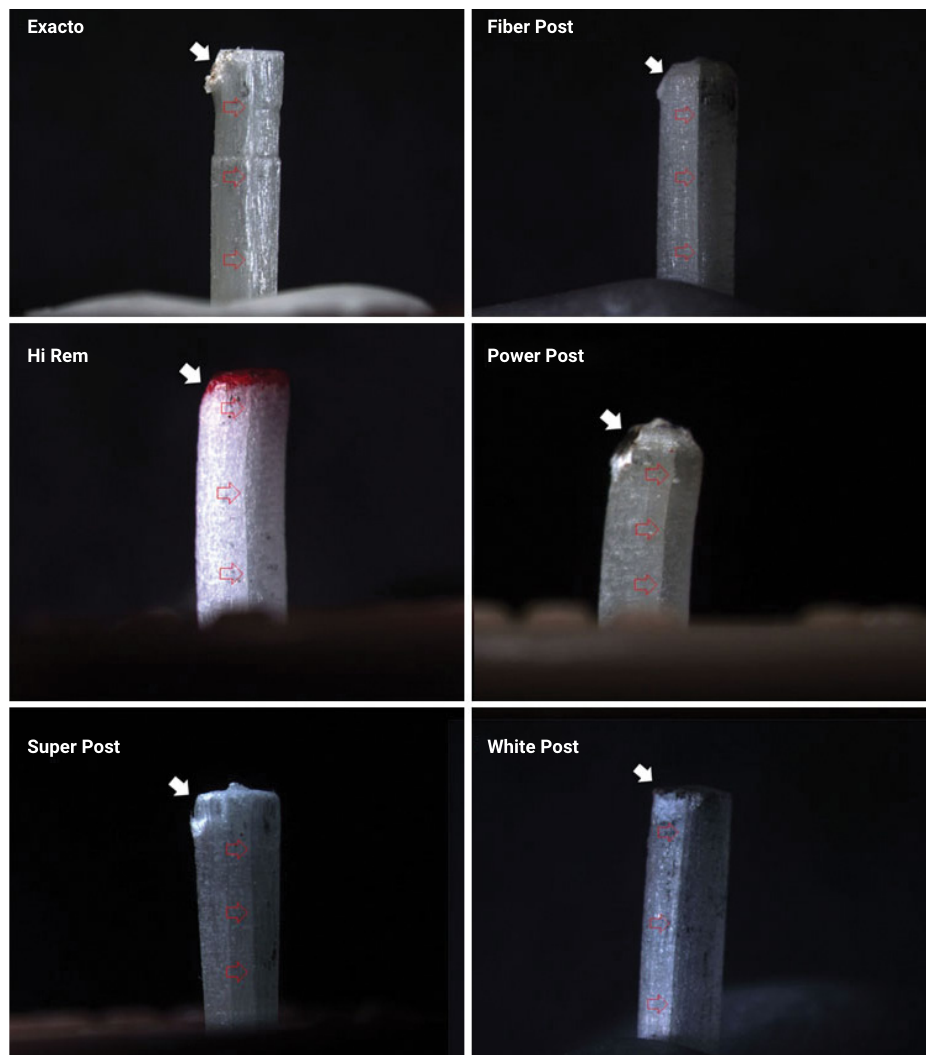
Figure 1. Representative images of the failure pattern. We can observe that the cracks occurs in the center of the specimen (red arrows), which is a characteristic of failure by shear stresses. The white arrow indicates the load application